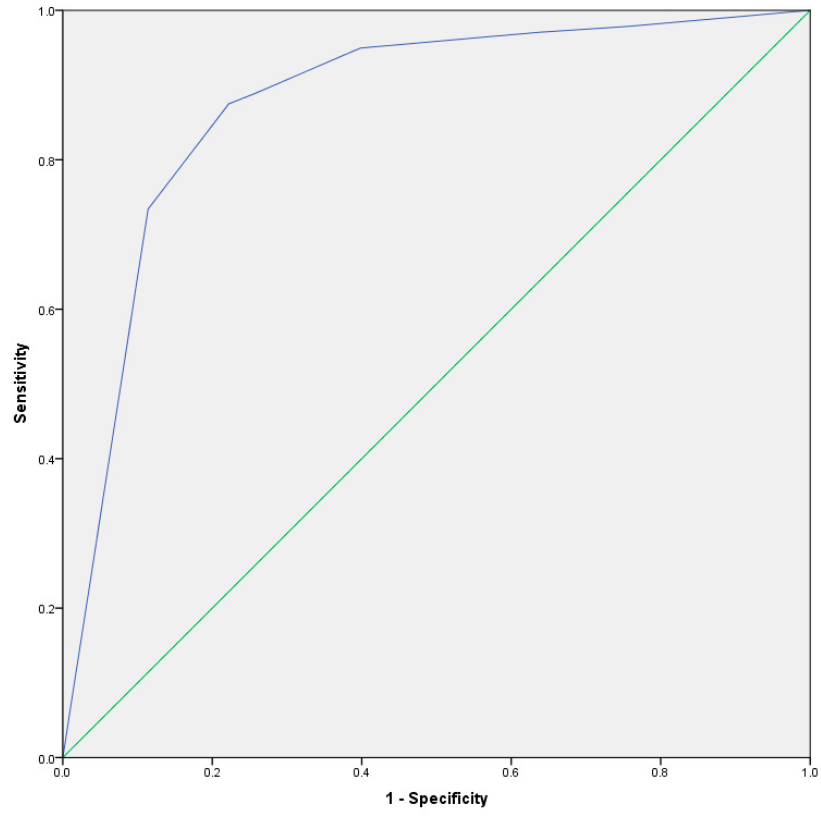
Figure 1. Receiver operating characteristic (ROC) curve for PEM duration.